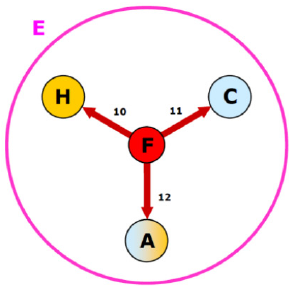
Fig. 4. – Heat exchange starting from primary